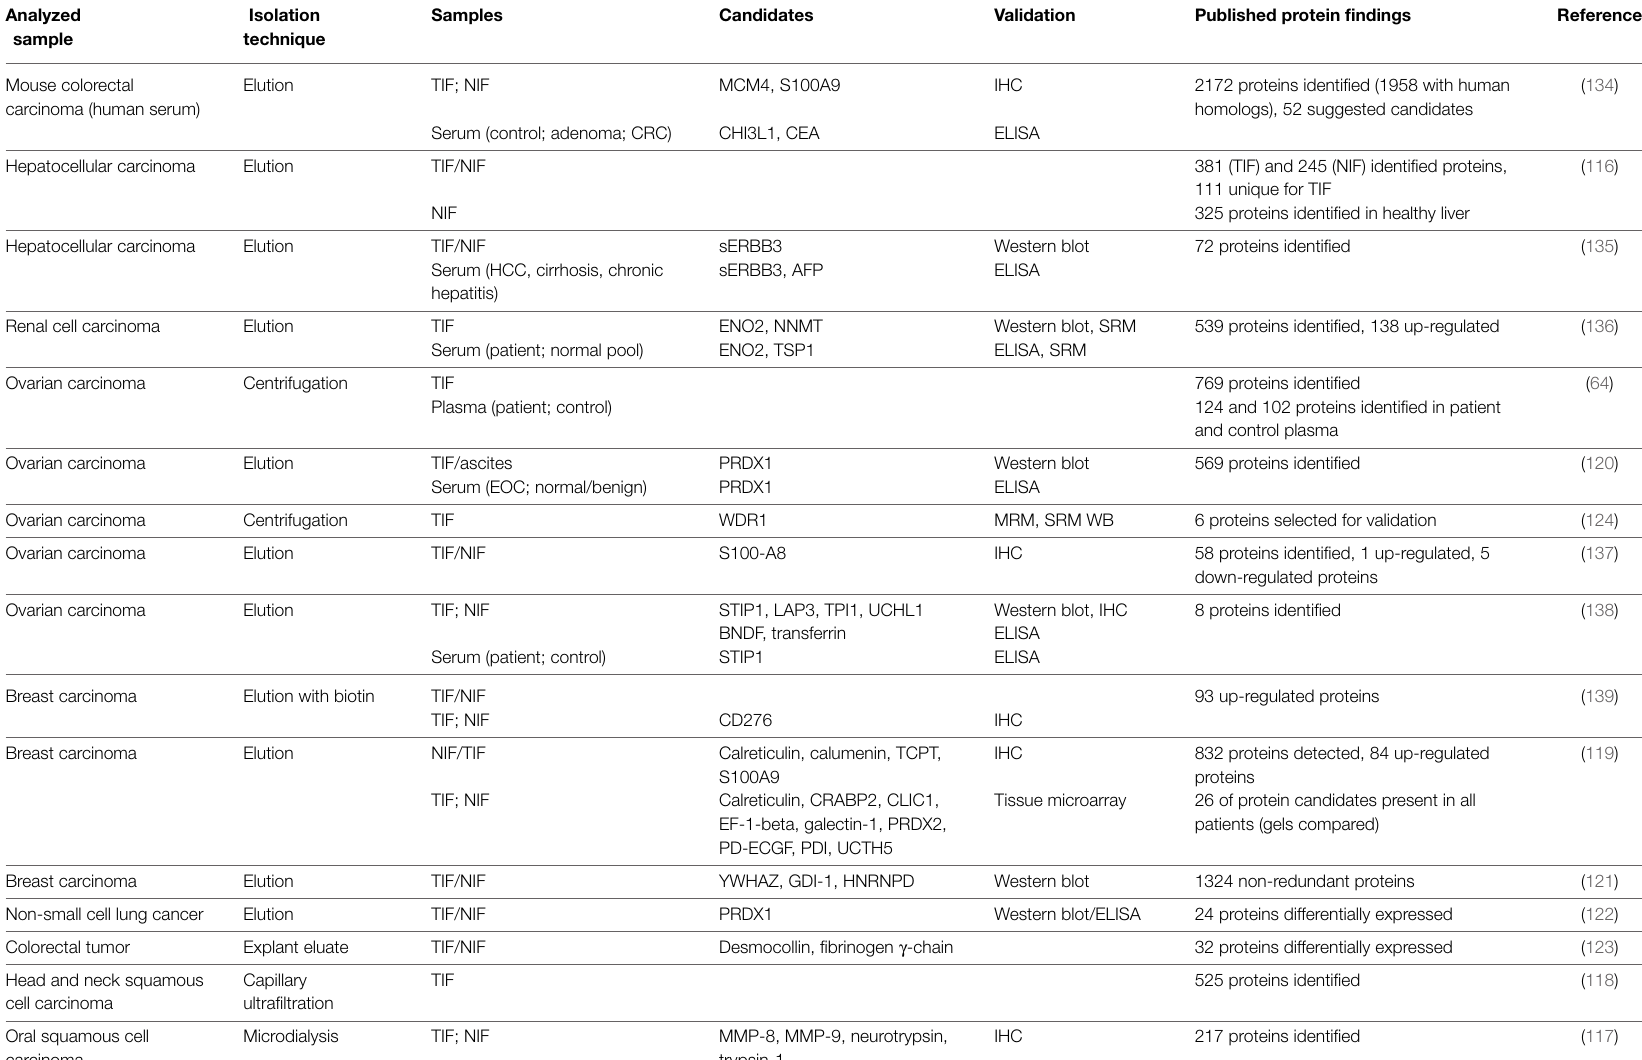
TABLE 2 | Summary of proteomic studies utilizing human tumor interstitial fluid, including candidate proteins that were chosen for validation . Analyzed